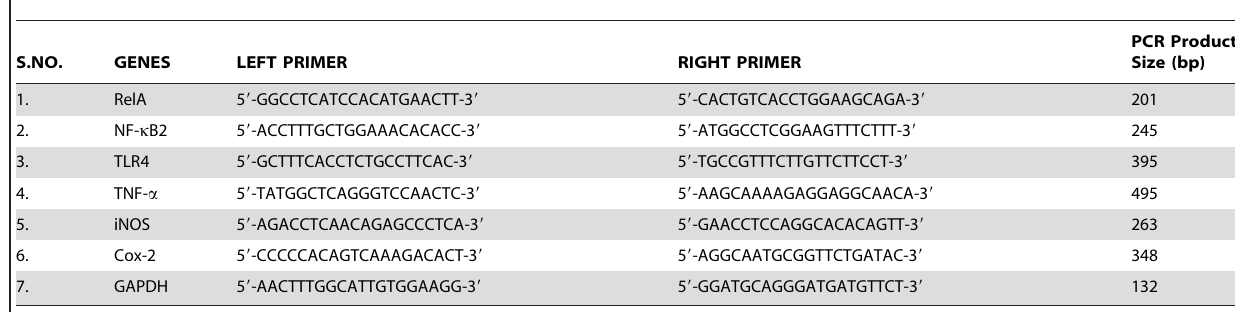
Table 1. List of primer sequence for genes.